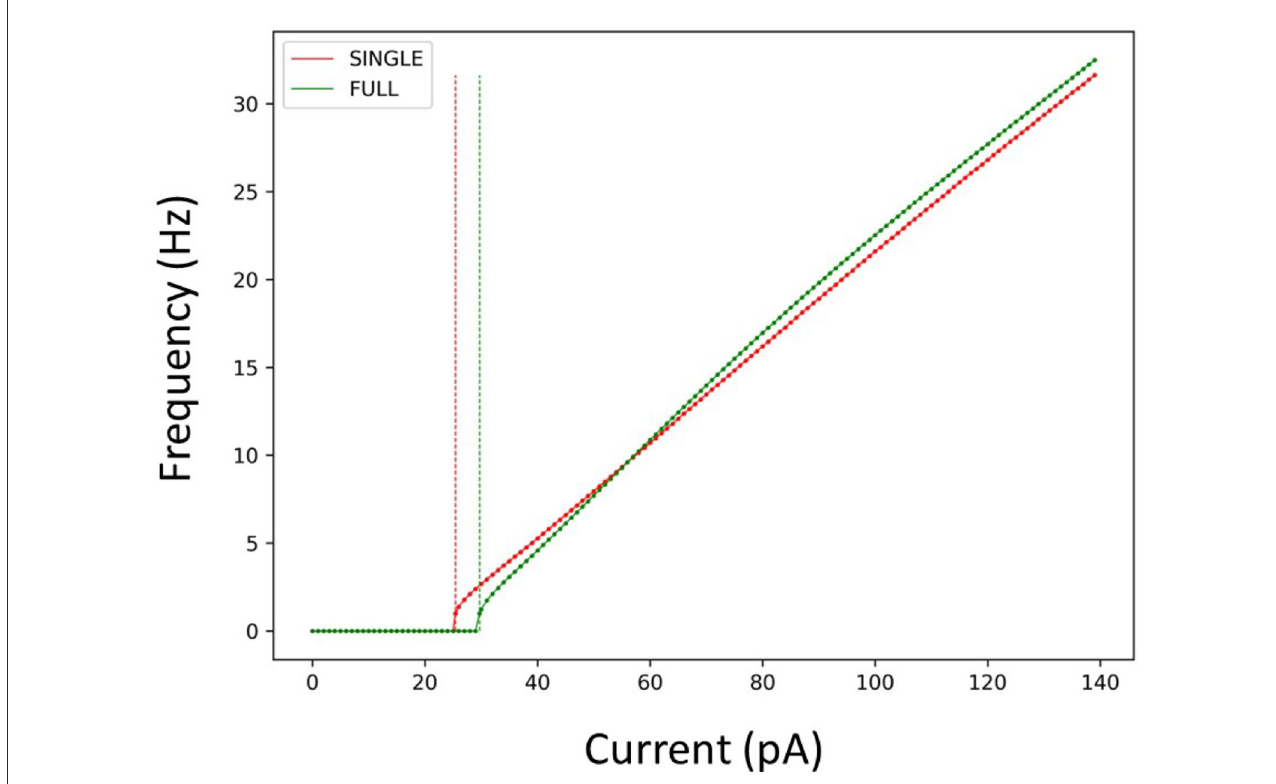
FIGURE2 Firing rates of SINGLE and FULL. The red and green dots and lines refer to the frequency vs current (f-I) curves for SINGLE and FULL, respectively. Correspondingly, the red and green dashed lines signify the amount of injected current needed to obtain a firing rate of 1 Hz in SINGLE and FULL. 25.5 pA for SINGLE and 29.7 pA for FULL.